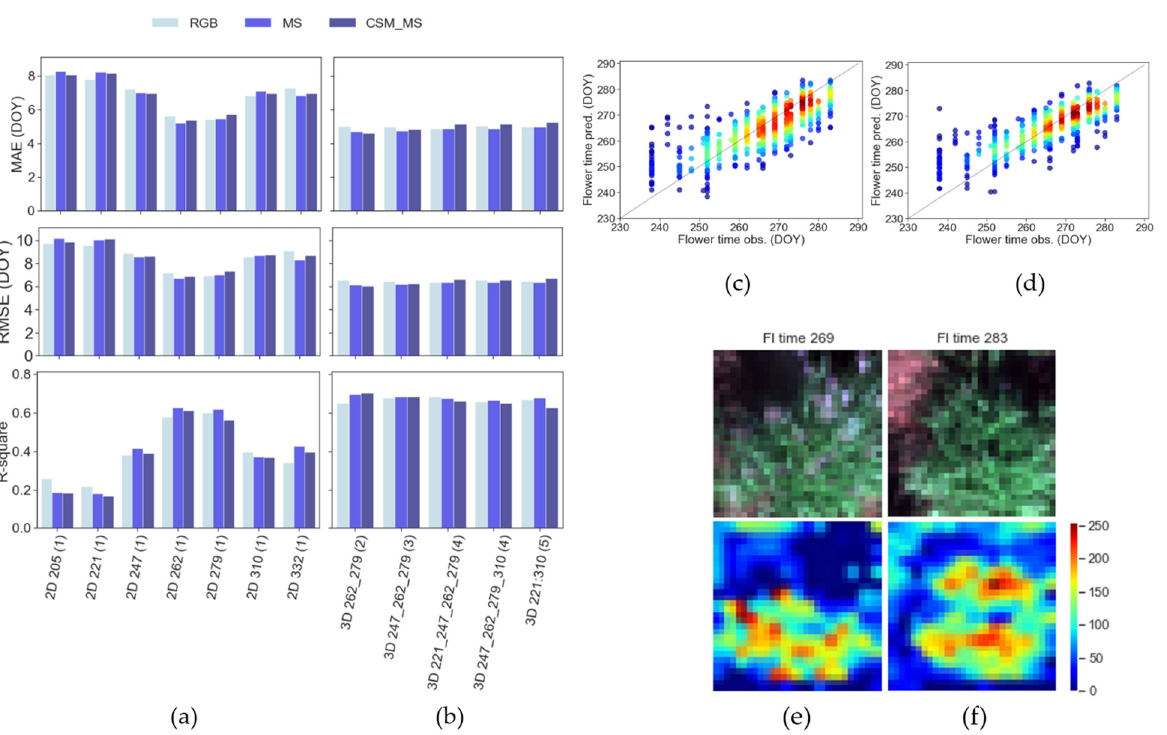
Figure 4. Evaluation of flowering time prediction in testing data for ( a ) 2D models by DAP and ( b ) 3D models by number of time-frame sequences via the MAE, RMSE, and R 2 metrics. Observed and predicted values for the best ( c ) 2D models and ( d ) 3D models for testing datasets with low- (blue) to high-density (red) sample distribution. Example RGB image chips and activation maps for ( e ) early- and ( f ) late-flowering-time plants from the 2D-based model of aerial data collected on DOY 279. The level of activation of the deepest CNN layers in the images is represented by low (blue), intermediate (yellow), and high (red) values on a 0–255 scale.